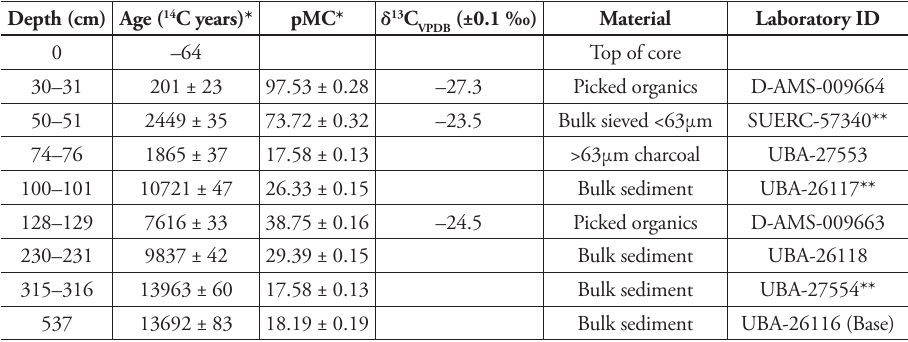
Table 1. Age determinations for the 537 cm Enapuiyapui Swamp stratigraphy. *1 σ error. pMC, percent modern carbon, defined as 1950 common era by 14 C activity standard. ** Dates that were excluded from the age-depth